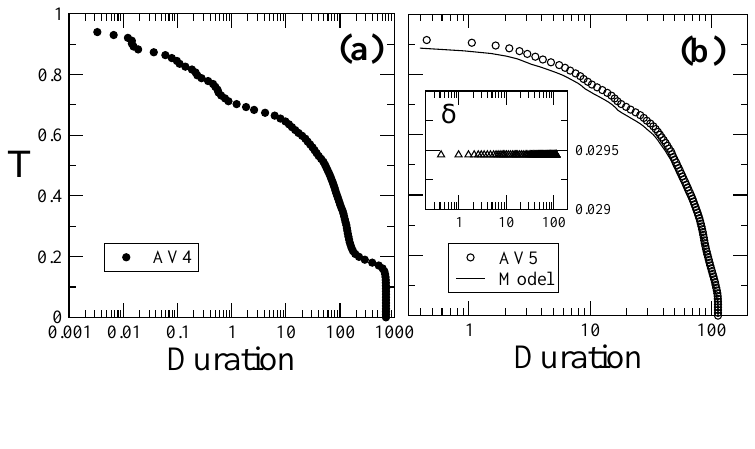
Figure 9. Load duration distribution (LDD) observed for the load series at ( a ) AV4 and ( b ) AV5. While for AV4, the empirical data were used for deriving the model, for AV5, one uses the derived model for reconstructing the data and comparing the estimated loads with the observed ones. In the inset, we show the relative deviation η shown in Equation (9) of the estimate with respect to the results for the